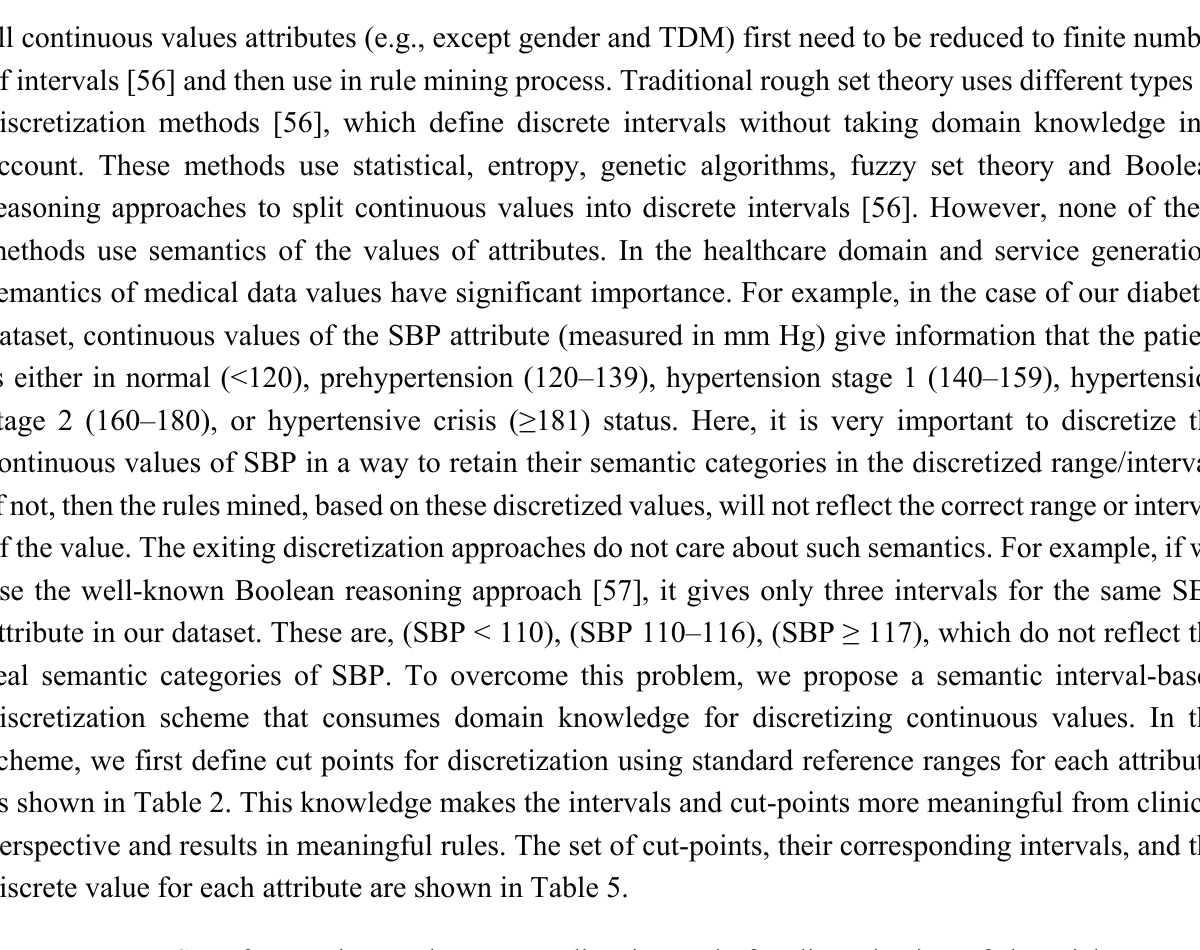
Table 5. Set of cut-points and corresponding intervals for discretization of the Diabetes Mellitus Information System